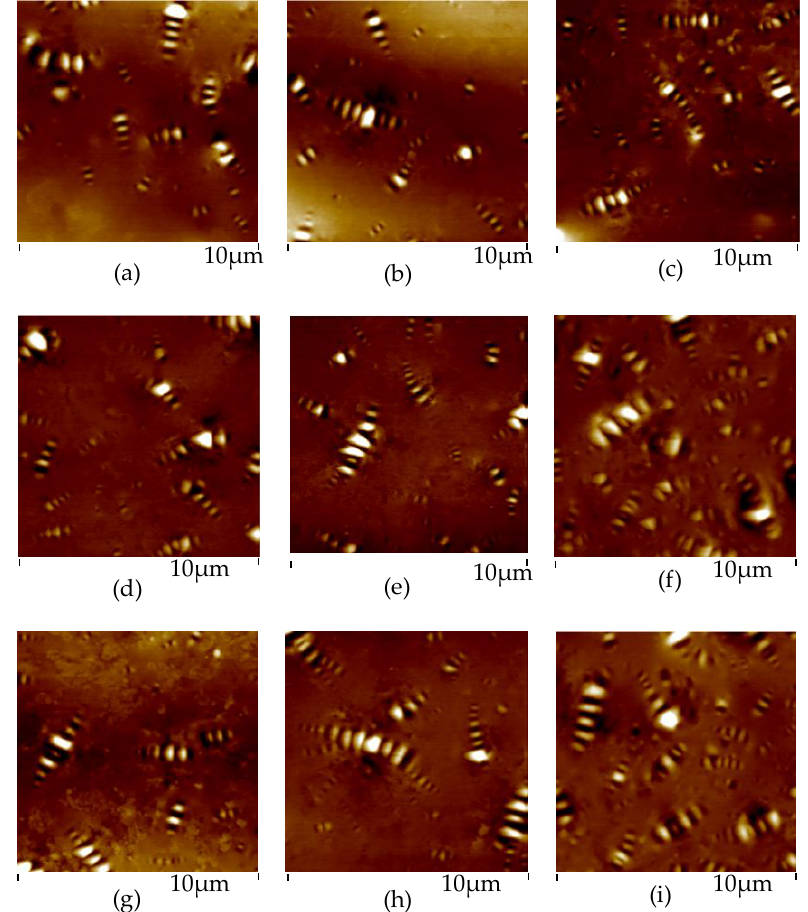
Figure 5. AFM images of bitumen with different ageing degree. The cooling rate of ( a – c ) is 12 °C/min; The cooling rate of ( d – f ) is 2 °C/min; The cooling rate of ( g – i ) is 1 °C/min; The ageing time of ( a , d , g ) is 0 min; The ageing time of ( b , e , h ) is 85 min; The ageing time of ( c , f , i ) is 240 min.